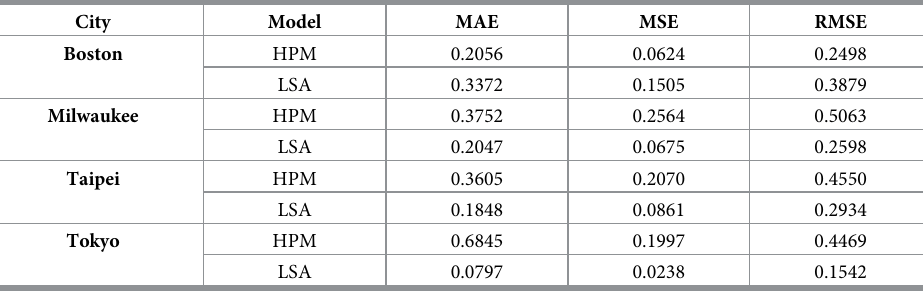
Table 3. Comparisons of the statistical errors obtained using HPM and LSA models for each